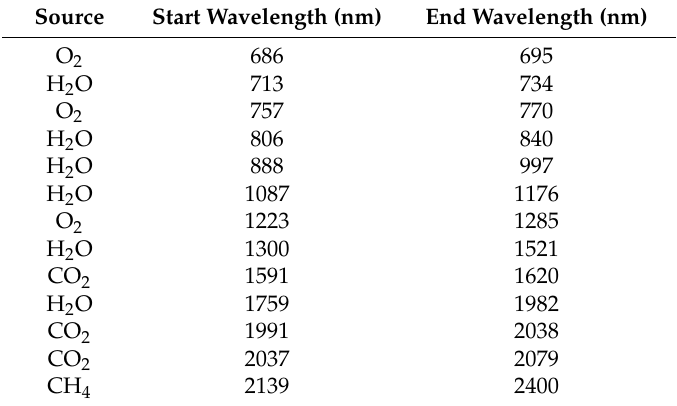
Table 2. The approximate spectral location of known atmospheric absorption features [43]. It is